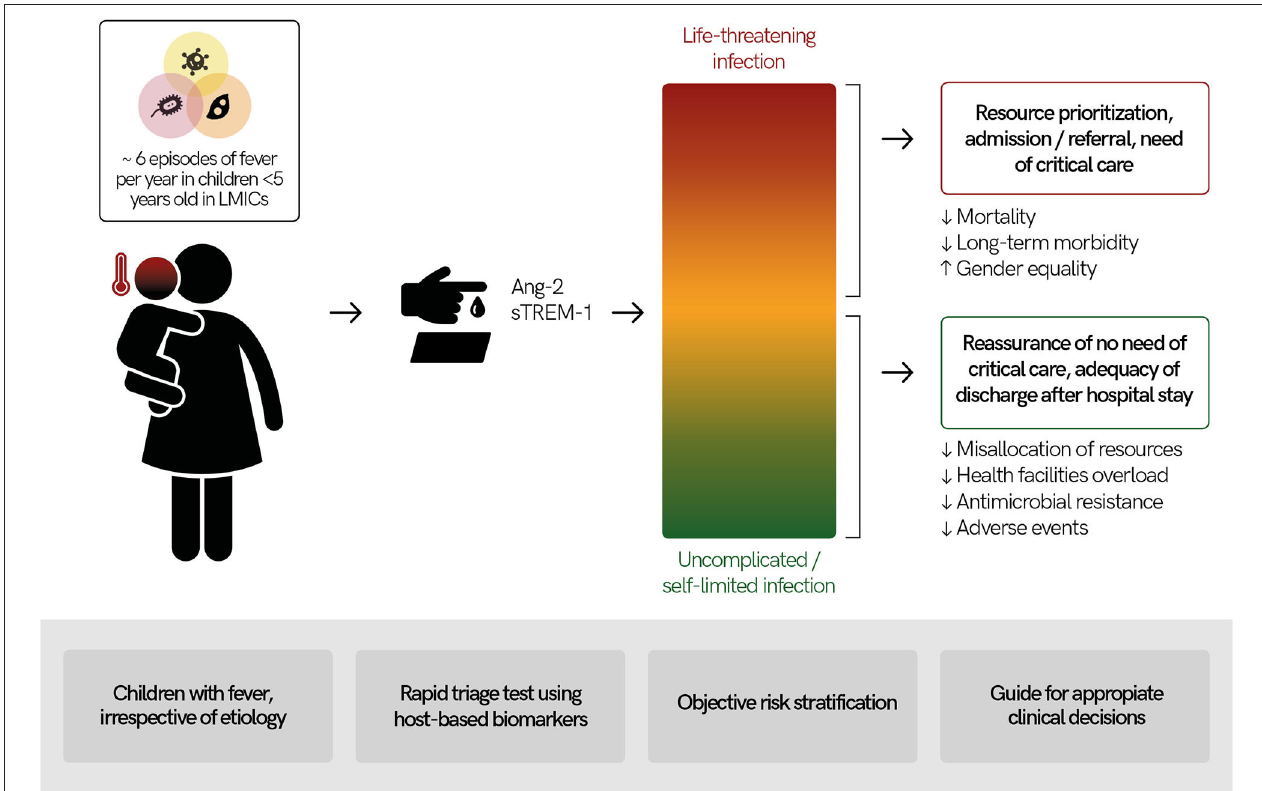
FIGURE 2 | Usefulness of a rapid triage “traffic light” test using host-based biomarkers for febrile children in low- and middle-income countries (LMICs). Febrile illnesses are among the most common causes for children to seek medical services in LMICs and their etiologies are diverse. Measuring host-based prognostic biomarkers for disease severity (e.g., angiopoietin-2 [Ang-2], soluble triggering receptor expressed on myeloid cells 1 [sTREM-1]) in febrile children could lead to objective child risk-stratification. Results of a rapid triage test at point-of-care would provide actionable results for health workers, guiding appropriate clinical decision-making. This has the potential to lead to better health outcomes as well as economic savings.